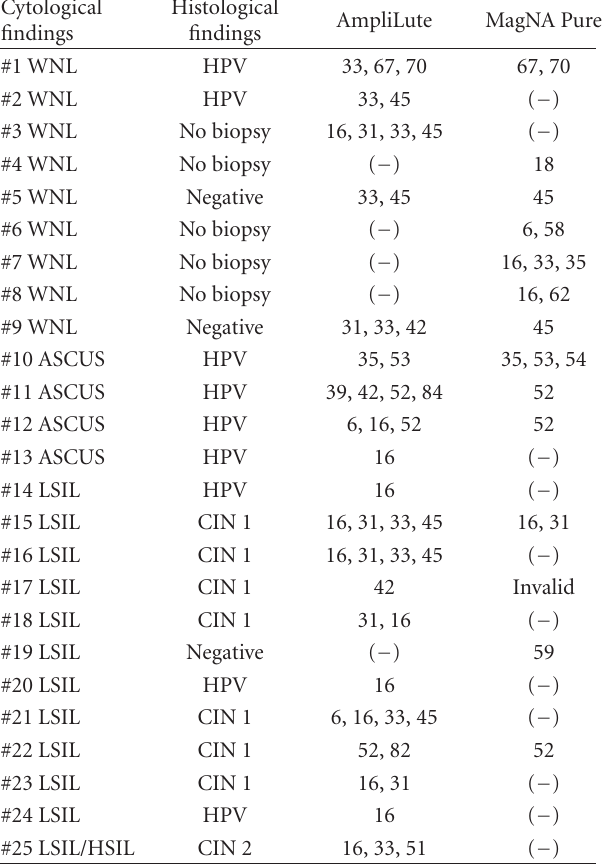
Table 3: Analysis of cases with discrepant results.